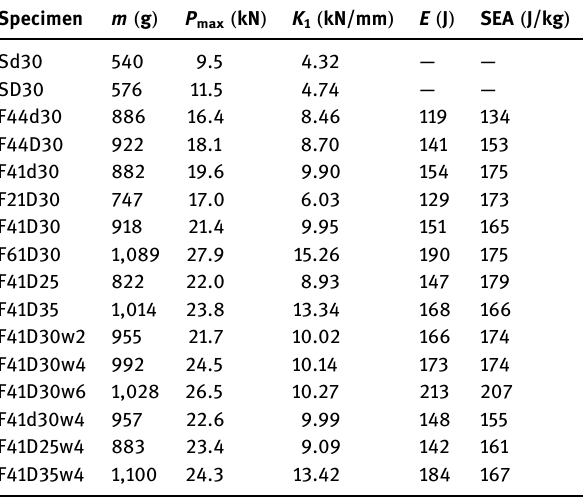
Table 4: Summary of test matrix and